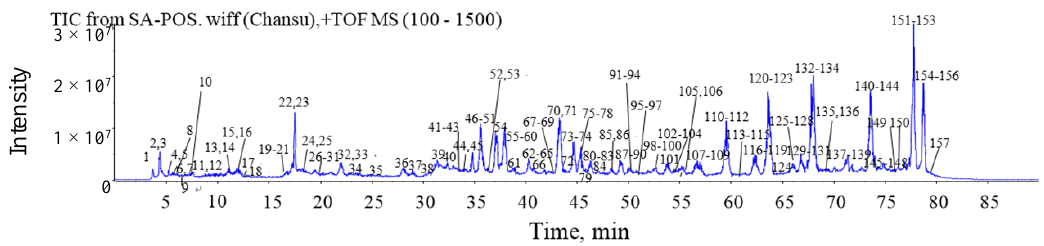
Figure 1. The total ion chromatograms (TICs) of Chansu methanol extracts in the positive ion mode.